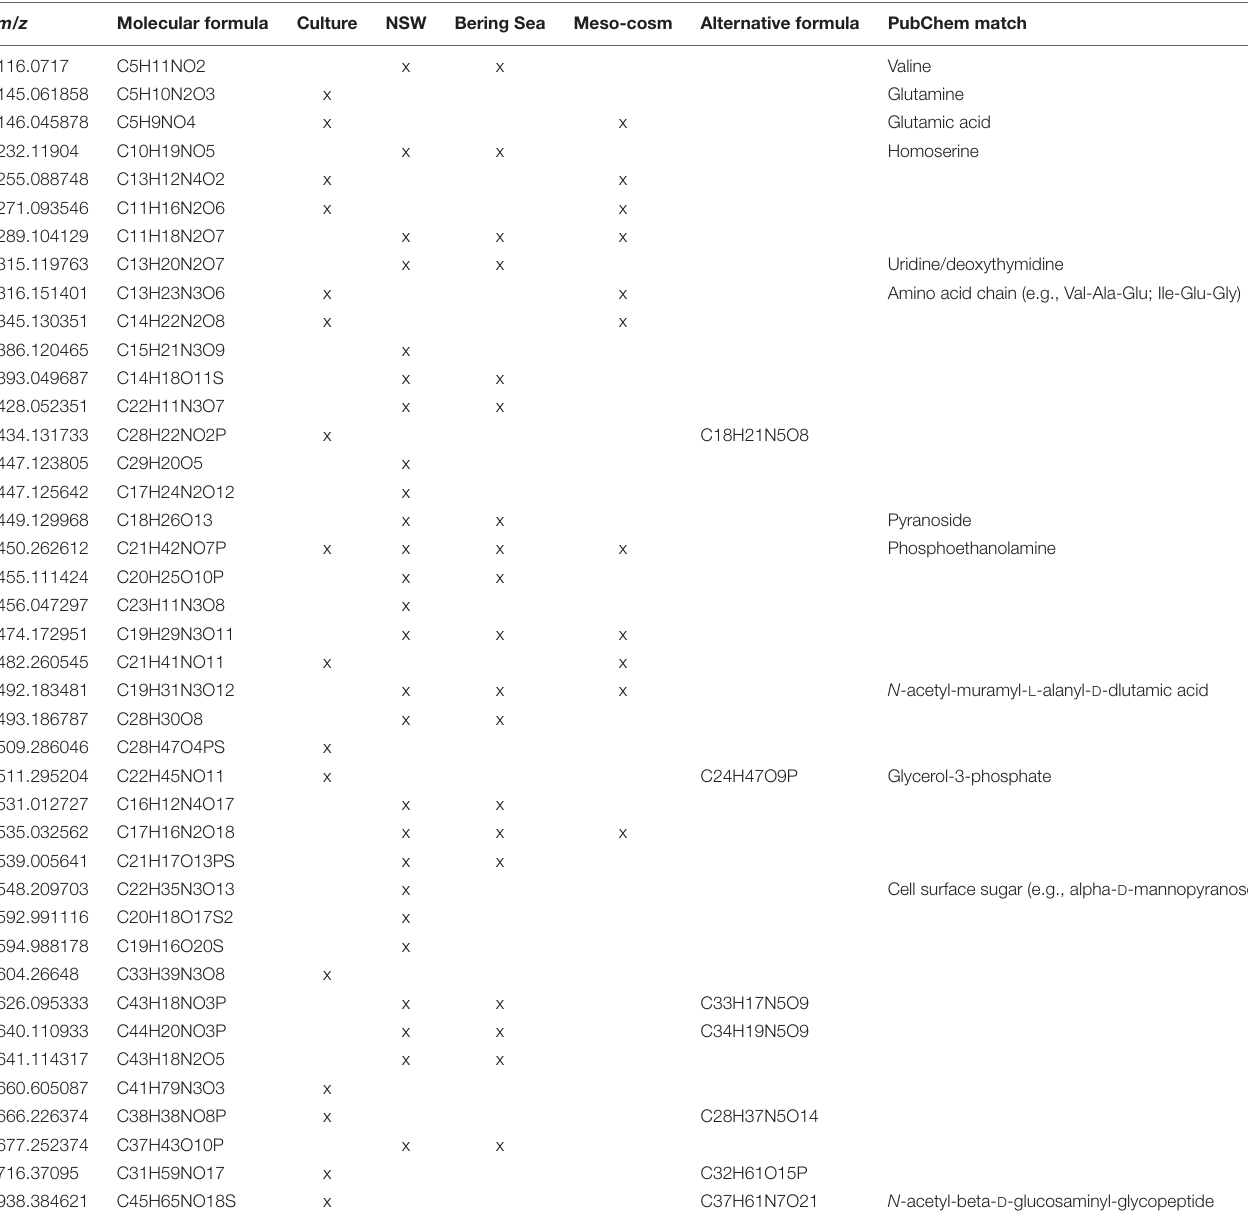
TABLE 1 | Mass to charge ratio ( m/z ) and molecular formulae from all filter fractions that significantly ( p < 0.05) correlated with virus abundances, detected in the Rhodovulum sulfidophilum culture (Culture), North Sea water spiked with R. sulfidophilum (NSW), prophage-induction of deep-sea sediment slurries (Bering Sea) (Heinrichs et al., 2020) and a mesocosm with a North Sea phytoplankton bloom (Mesocosm) (unpublished). m/z Molecular formula Culture NSW Bering Sea Meso-cosm Alternative formula